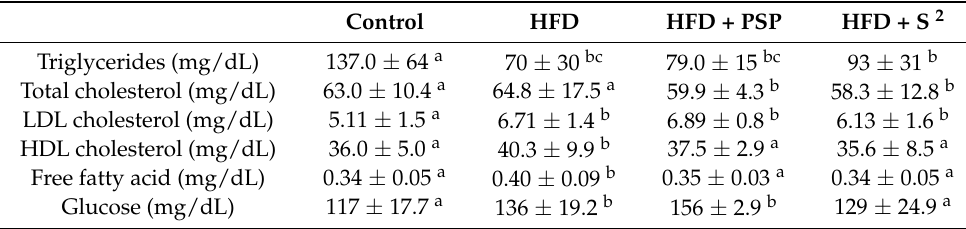
Table 3. Effects of PSP on the blood biochemistry values in Sprague Dawley rats exposed to HFD 1